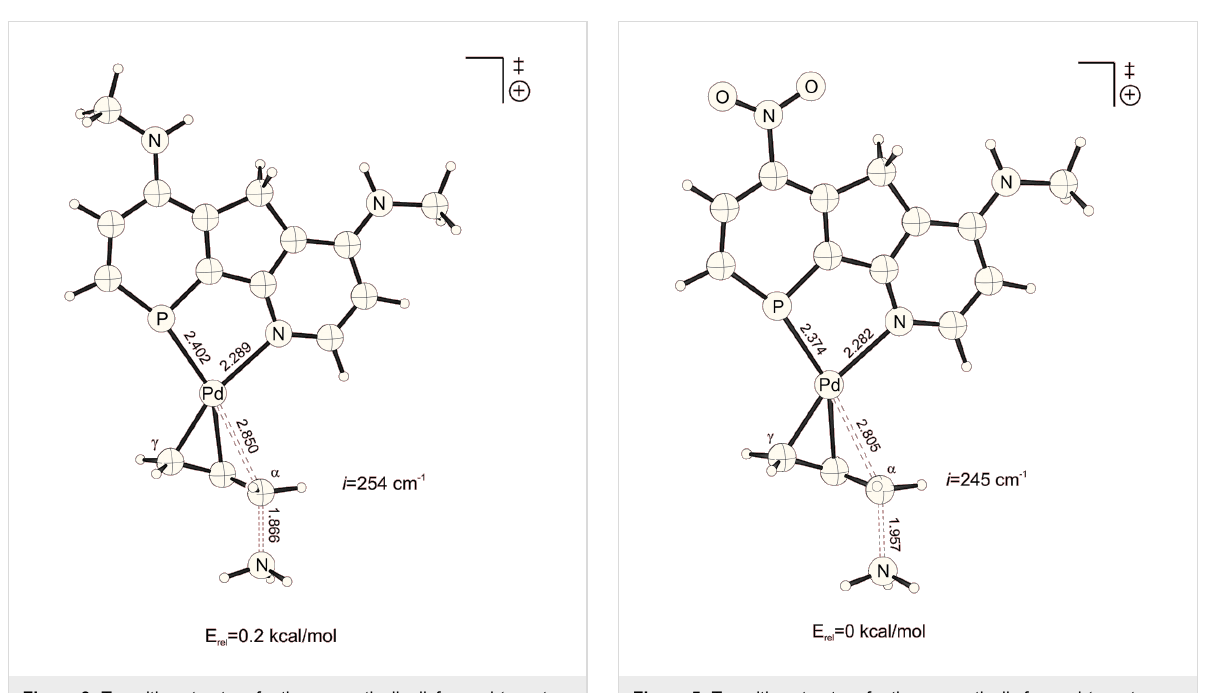
Figure 3: Transition structure for the energetically disfavored trans to phosphorus addition of ammonia at the Pd-η 3 -allylic intermediate (B3LYP/6-31G* (C, H, N, P, O), /SDD (Pd)). Bond distances are given in Å.